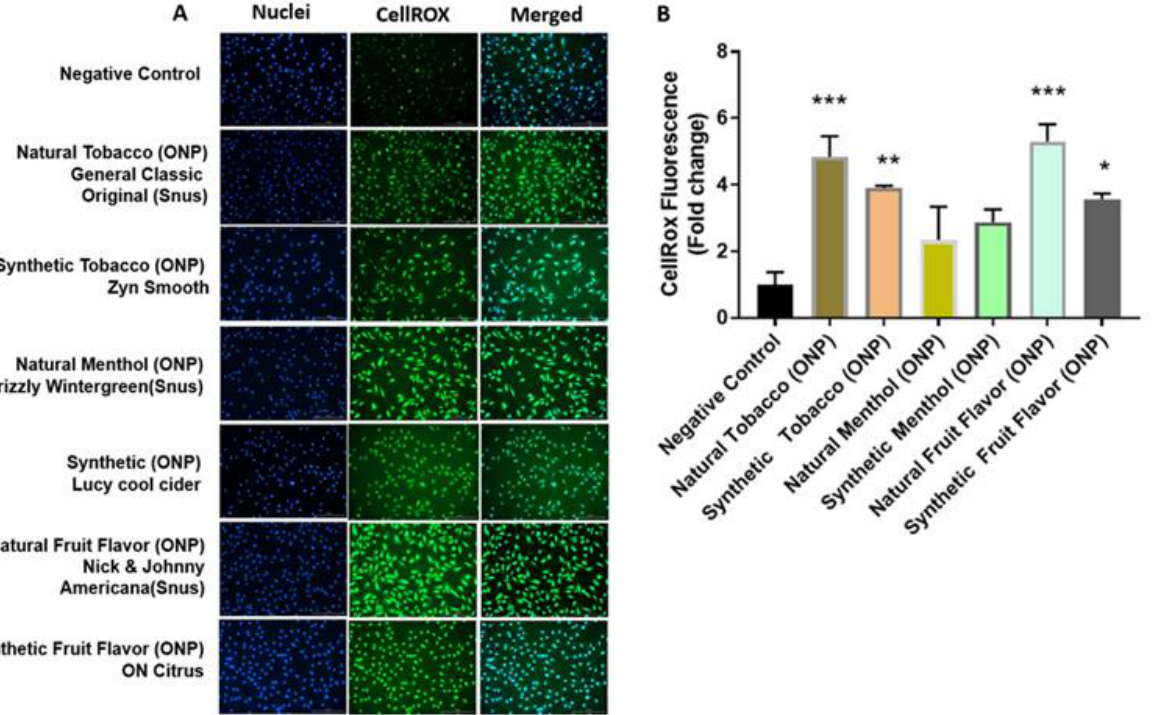
Figure 5. ROS production in Human gingival epithelium progenitors (HGEPp) . HGEPp cells were treated at 3% dosage with extracts of oral pouches categorized with natural/synthetic tobacco, men- thol, and fruit flavors) belonging to different brands (Snus, Zyn, Grizzly, Lucy, and ON) and incu- bated for 4 h. Followed by 4 h exposure, cells were exposed to a 5 µM CellRox Green Reagent. Then, were fixed with PFA and nuclei were counterstained with Hoechst 33,342 stain. ( A ) Fluorescence images display the release of ROS and nuclei (blue) in HGEPp. ( B ) Quantitative analysis of fluores- cence. Data are represented as mean ± SEM. * p < 0.05, ** p < 0.01, *** p < 0.001. Images were captured by Cytation 5 imaging reader (BioTek) reader and CellROX fluorescent signals were quantified us- ing Image J software ( n = 3). Scale bar = 200 μm.